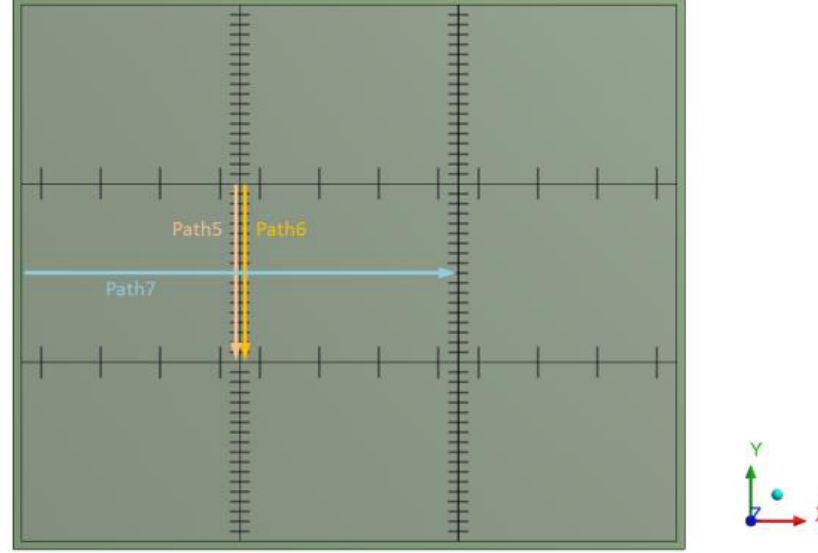
Figure 6. Global positions of paths at bottom parts of concrete slabs.